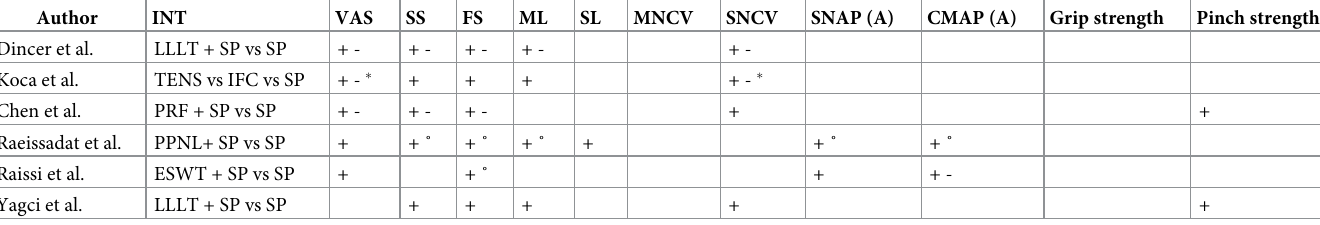
Table 4. Outcome measures and significance of electrophysical modalities versus